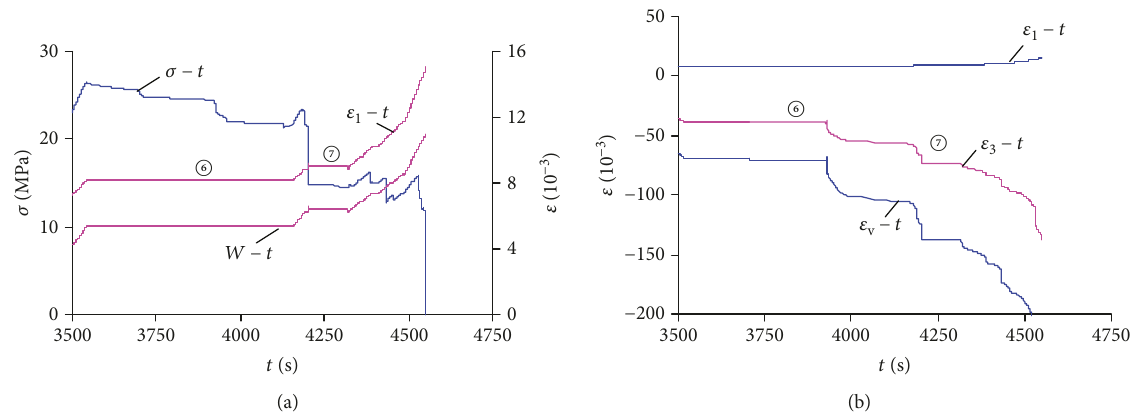
Figure 6: Stress (strain, energy) versus time curves for the sixth and seventh state relaxation